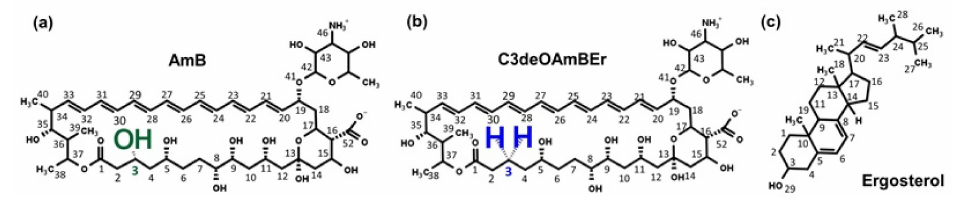
Figure 1. Chemical structures of simulation material monomers; ( a ) Amphotericin B (AmB), ( b ) mod- ified Amphotericin B (C3deOAmBEr) and ( c ) Ergosterol